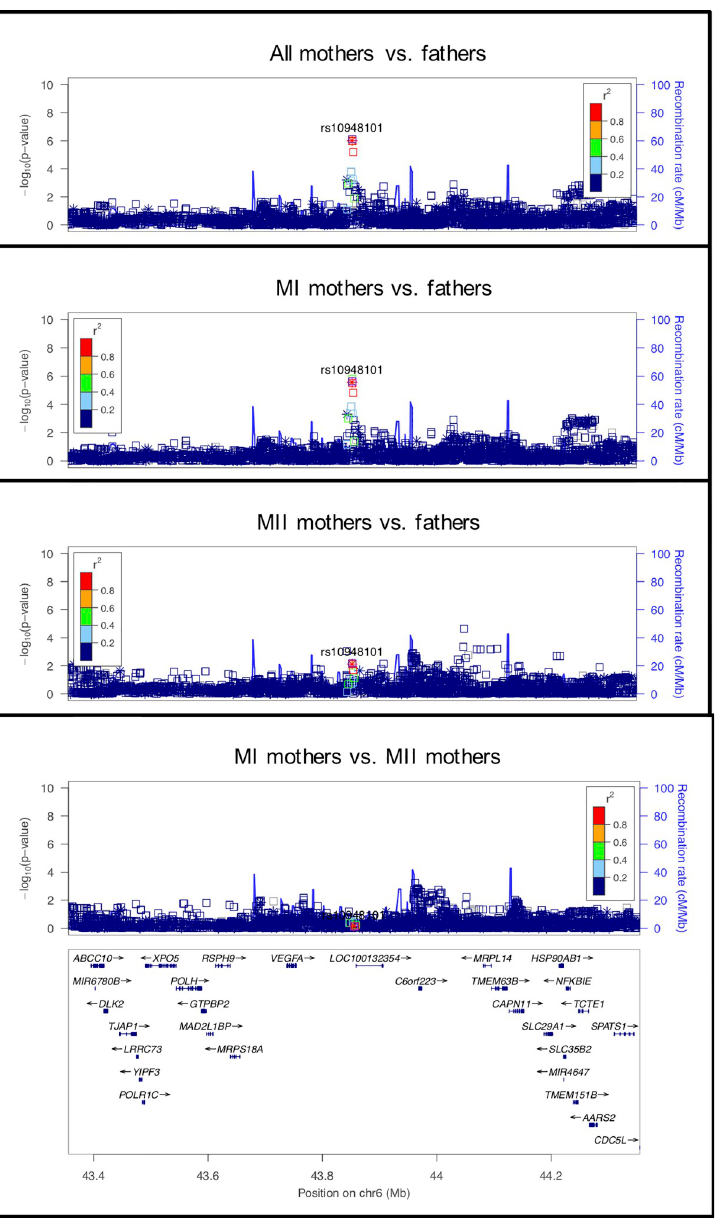
Fig 6. LocusZoom plot for VEGFA